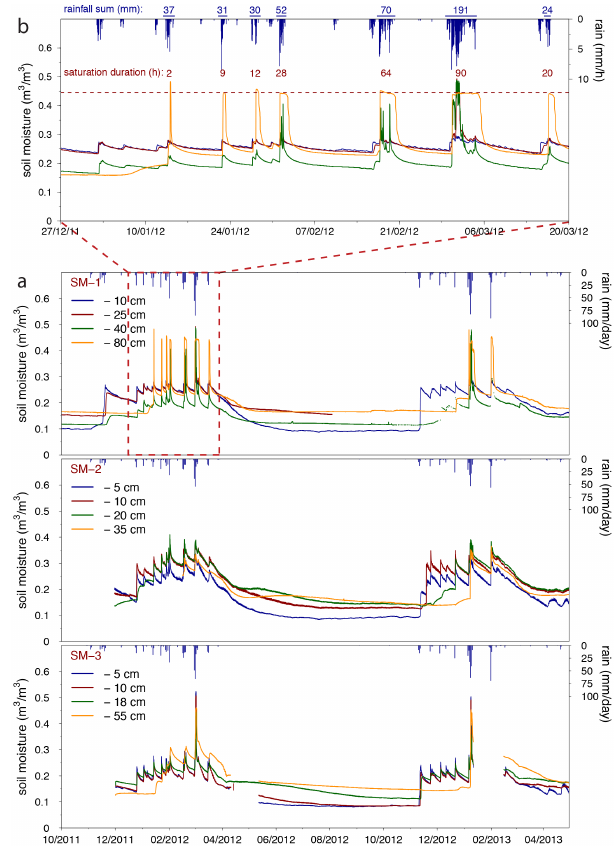
Figure 4. Observed volumetric soil moisture at different depths of the three experimental plots during the complete monitoring period (a) and details on the winter season 2011/2012 for plot SM-1 (b)